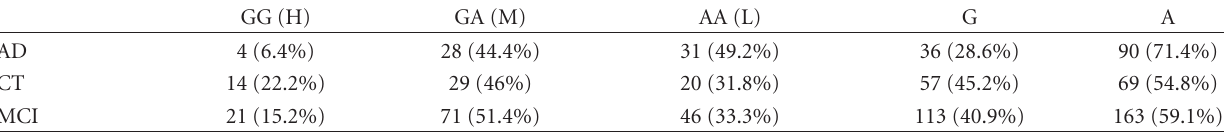
Table 1: Distribution of genotype and allele frequencies of − 1082 (G/A) SNP in Alzheimer’s disease patients (AD), control subjects (CT), and mild cognitive impairment patients (MCI).